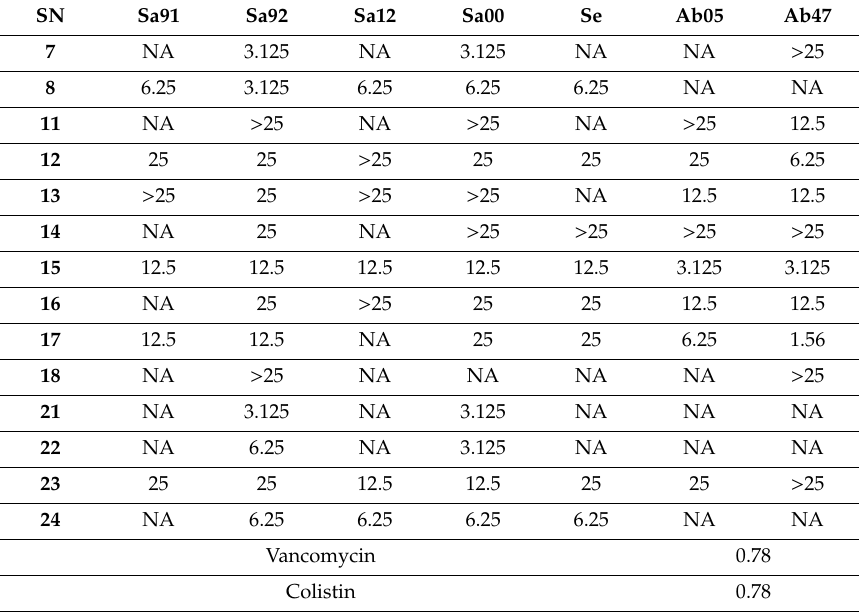
Table 2. Antimicrobial properties of the lead molecules against S. aureus ATCC 33591 (Sa91), S. aureus ATCC 33592 (Sa92), S. aureus ATCC 43300 (Sa00), S. epidermidis 700296 (Se), A. baumannii ATCC BAA-1605 (Ab05) and A. baumannii ATCC 747 (Ab47). NA = no activity (compounds did not show any noticeable activity up to 50 µ g / mL